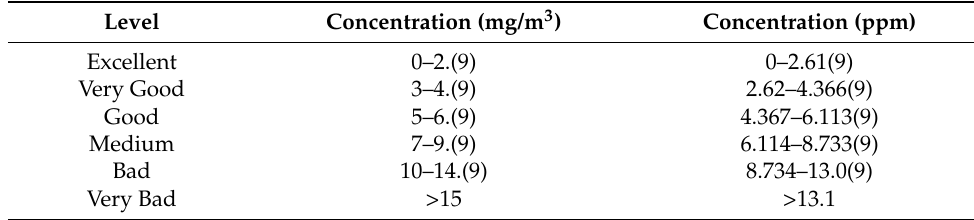
Table 1. CO exposure limits.